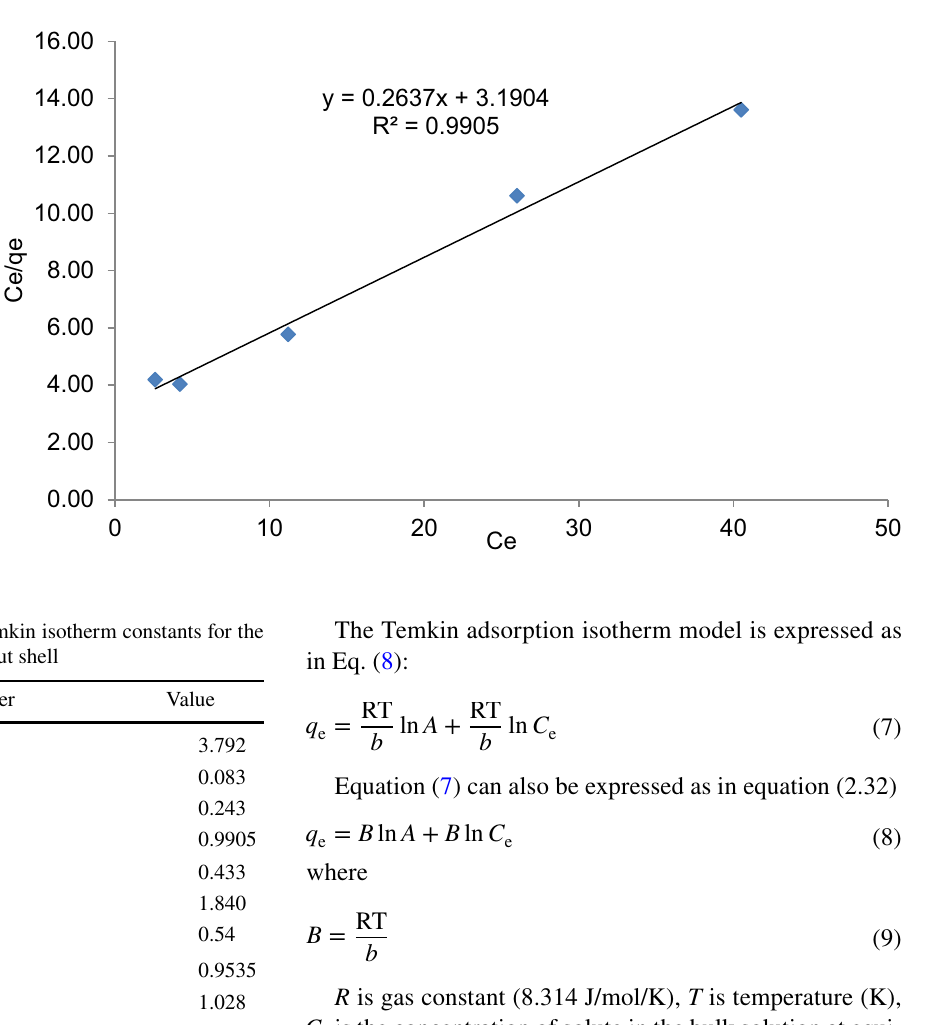
y = 0.2637x + 3.1904